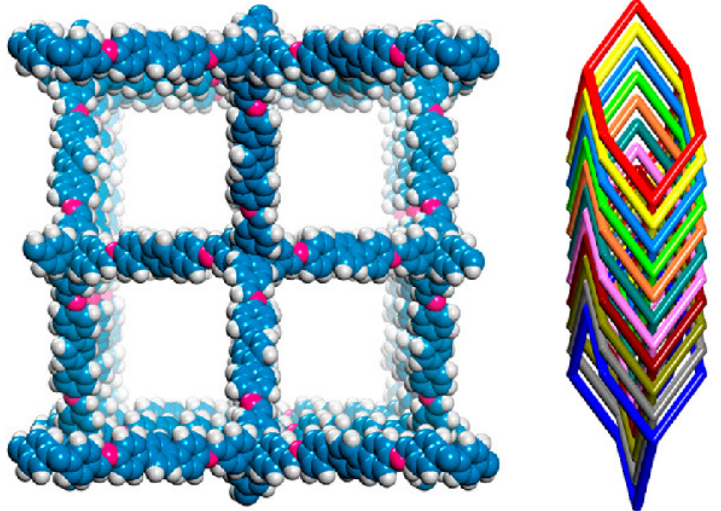
Figure 15. Structural presentation of 3D IL-COF. Reprinted (adapted) with permission from [55]. Copyright 2018 American Chemical Society.